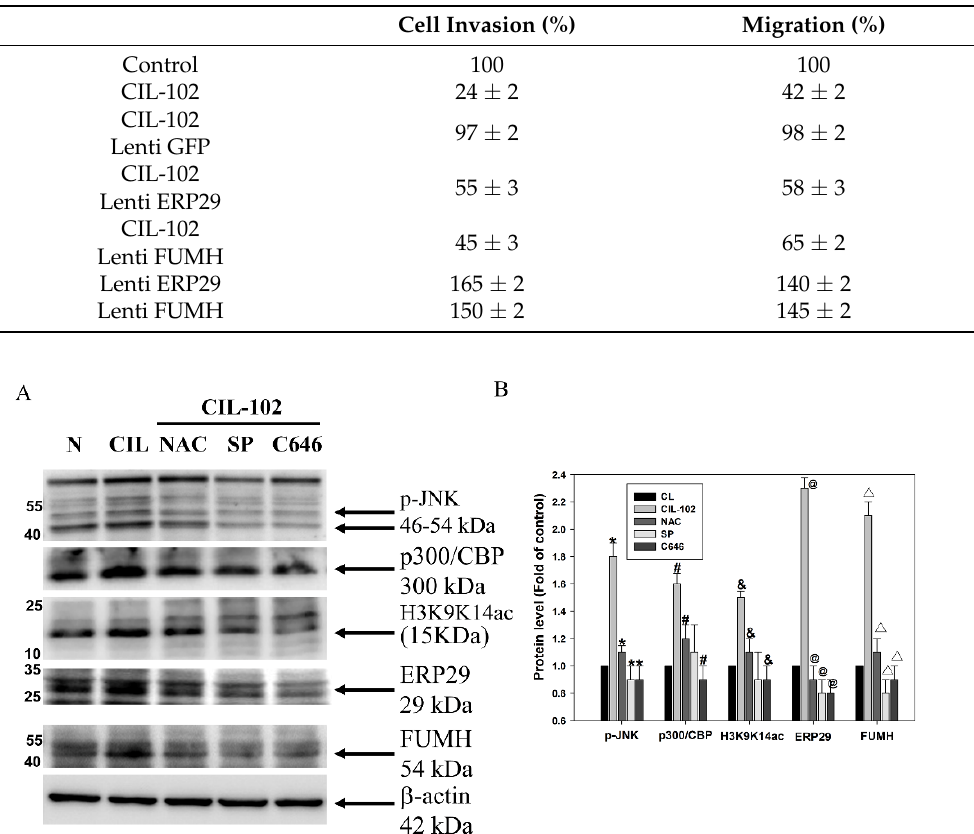
Figure 6. ROS production, histone acetylation, and JNK signal participate in the upregulation of ERP29 and FUMH by CIL-102. ( A ) DLD-1 cells were treated with kinase inhibitors (NAC for the inhibition of ROS production; SP is an inhibitor for the JNN signal; C646 is for the inhibition of acetyltransferase) in the presence or absence of CIL-102. One hour later, all cell lysates were prepared and subjected to a Western blot analysis. ( B ) The protein levels of phosphorylated JNK, p300/CBP and Histone H3 (H3K9K14ac), ERP29, FUMH, and β -actin were detected with the indicated antibodies and quantified by using a densitometric analysis. After normalization, β -actin served as loading control, and the data are presented as 100% of the untreated control group (means ± SD) from three independent experiments. * p < 0.05, p-JNK when compared with the untreated control group. # p < 0.05, p300/CBP when compared with the untreated control group. & p < 0.05, H3K9K14ac